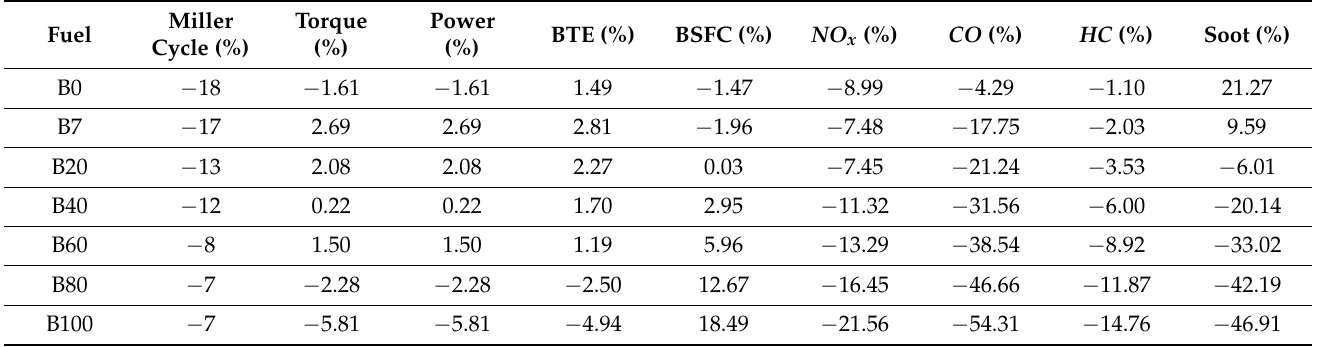
Table 6. Optimal results found for each fuel tested, combined with the use of the Miller cycle (given in % difference to baseline engine at the rated